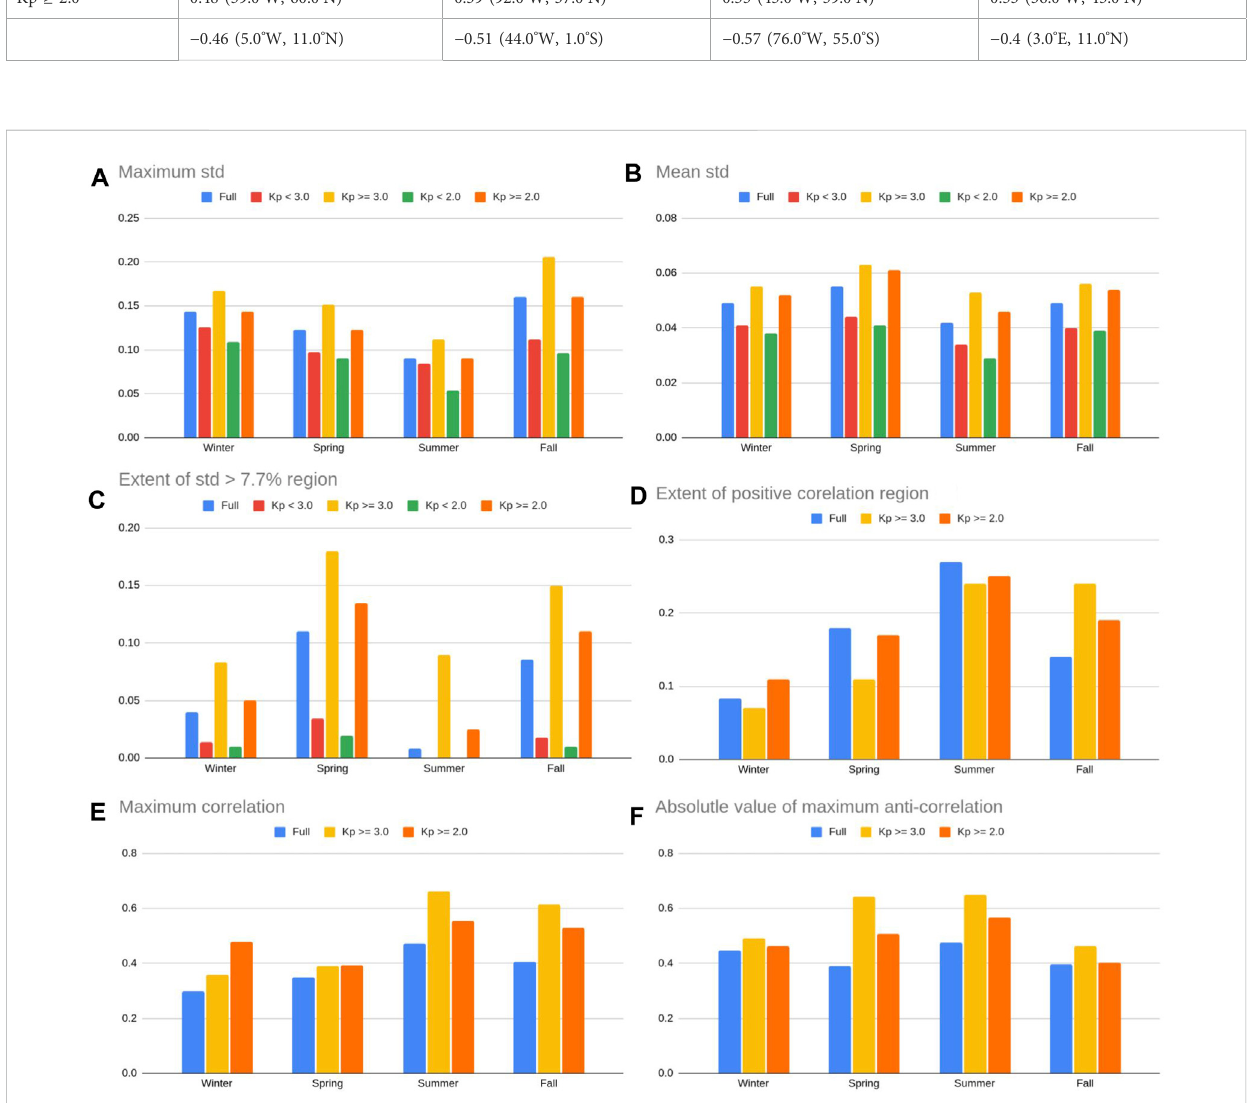
FIGURE 6 (A) Maximum and (B) mean standard deviation over the full disk for each season and each activity class. (C) Extent of the high variability region (relativestds ≥ 7.7%)asapercentageoftheGOLDfovforeachseasonandactivityclass. (D) Extentofthepositivecorrelationregionasapercentageofthe GOLD fov. (E) Maximum positive correlation and (F) absolute value of maximum anti-correlation for each season and activity